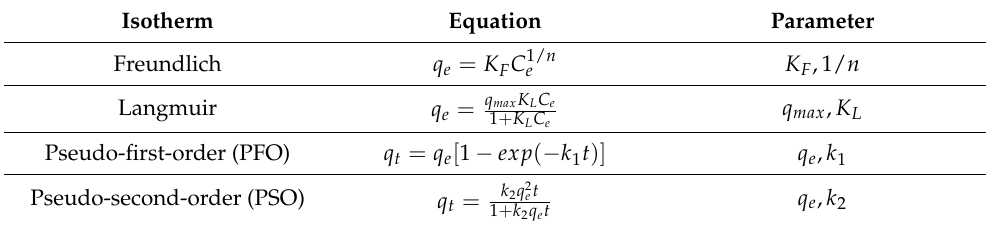
Table 1. The equations of the adsorption kinetic and isothermal